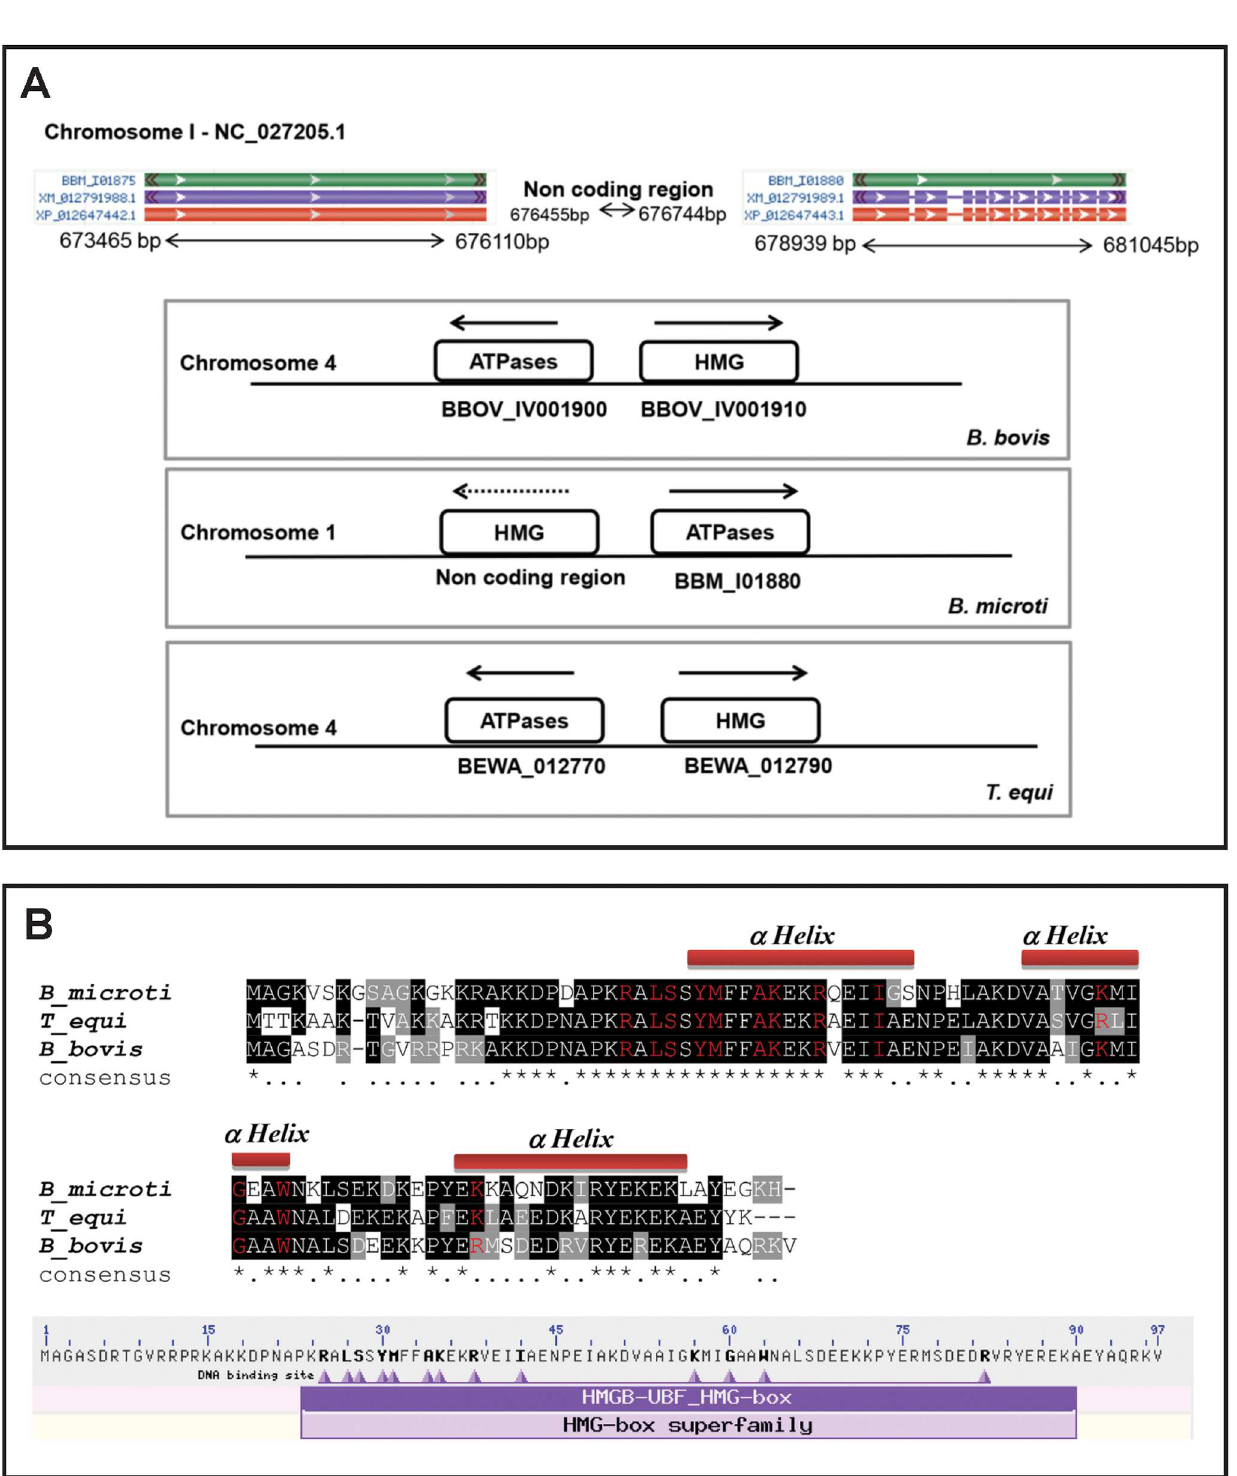
Fig 6. Putative HMG proteins and genes of B . bovis , T . equi , and B . microti . (A) Upper : Schematic representation of non-codingarea in B . microti genome between 676455bp and 676744bp in chromosome 1. Lower : Synteny map for the HMG genes in the B . bovis , B . microti , and T . equi . (B) Upper : Alignment of the deduced amino acid sequences of HMG proteins identifiedin B . bovis (BBOV_IV001910), T . equi (BEWA_012790), and B . microti (no gene assignment). The residues in red represent the amino acids defining the HMG domain Lower : Location of the HMG domain and depictionof the amino acid residues defining the HMG domain (bold fonts) in the HMG protein encoded by the B . bovis gene BBOV_ IV001910.